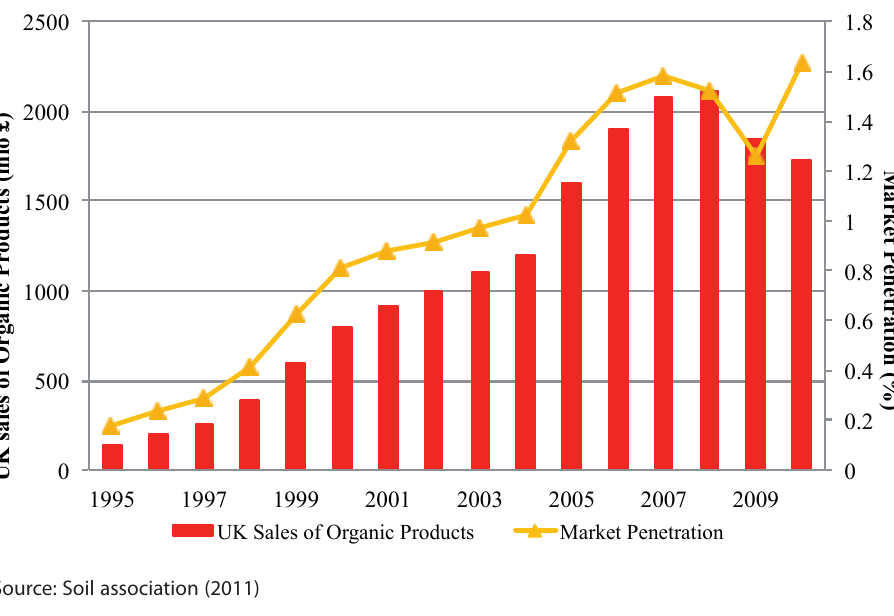
Figure 7. Organic food sales and market penetration of organic food sales in the UK (sales in mio £, market penetration in %;